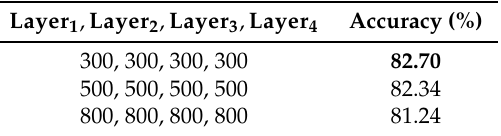
Table 8. Average classification results for an RBM with four hidden layers using the AAhydro set.